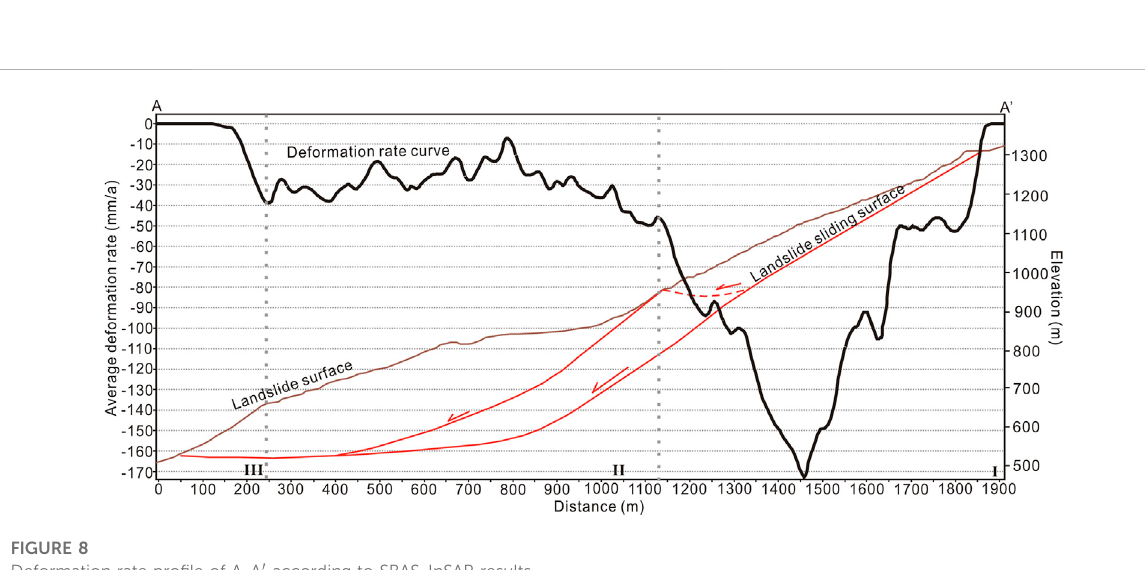
FIGURE 8 Deformation rate pro fi le of A-A ′ according to SBAS-InSAR